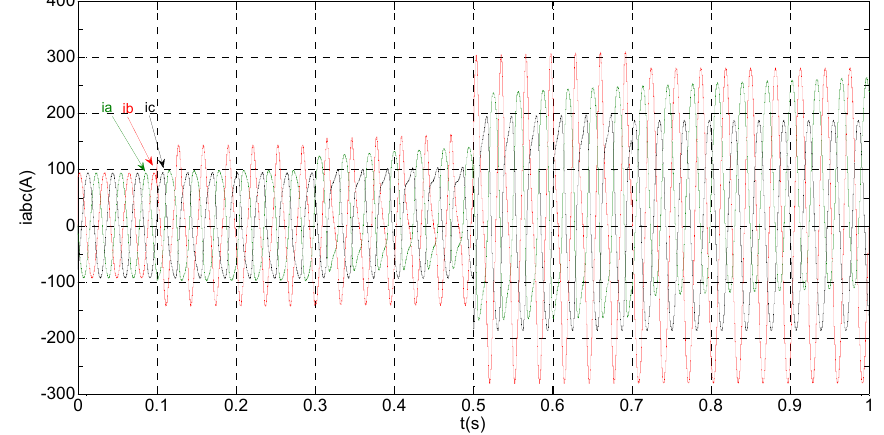
Figure 9. The measured value of three-phase current.